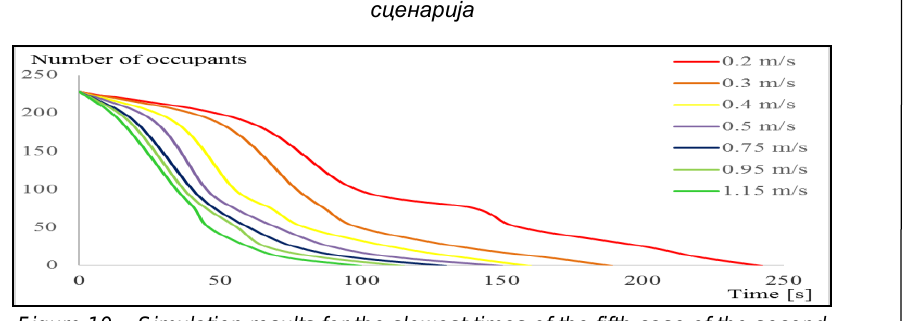
Figure 19 – Simulation results for the slowest times of the fifth case of the second